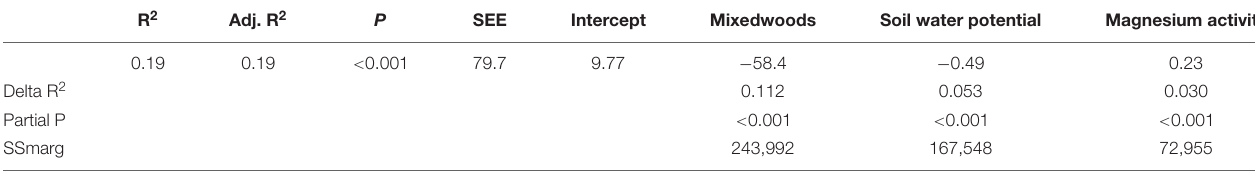
TABLE 4 | Multiple linear regression of the residuals of the general exponential relationship between soil respiration and soil temperature. R 2